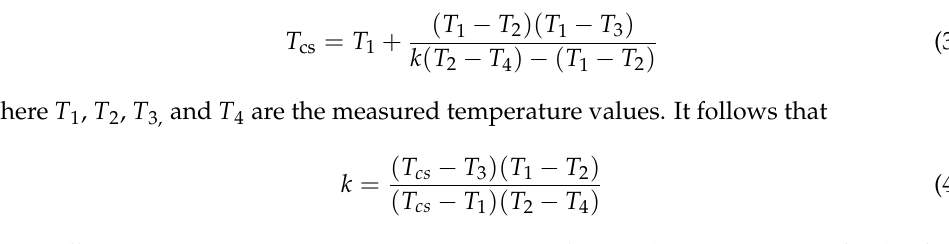
Figure 5. Calibration device mimicking the forehead.